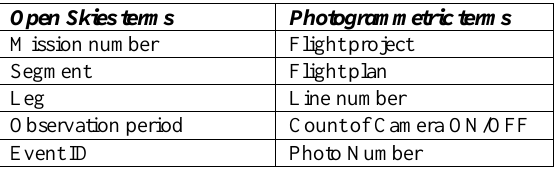
Table 1. Comparison between Open Skies and Photogrammet- ric terms